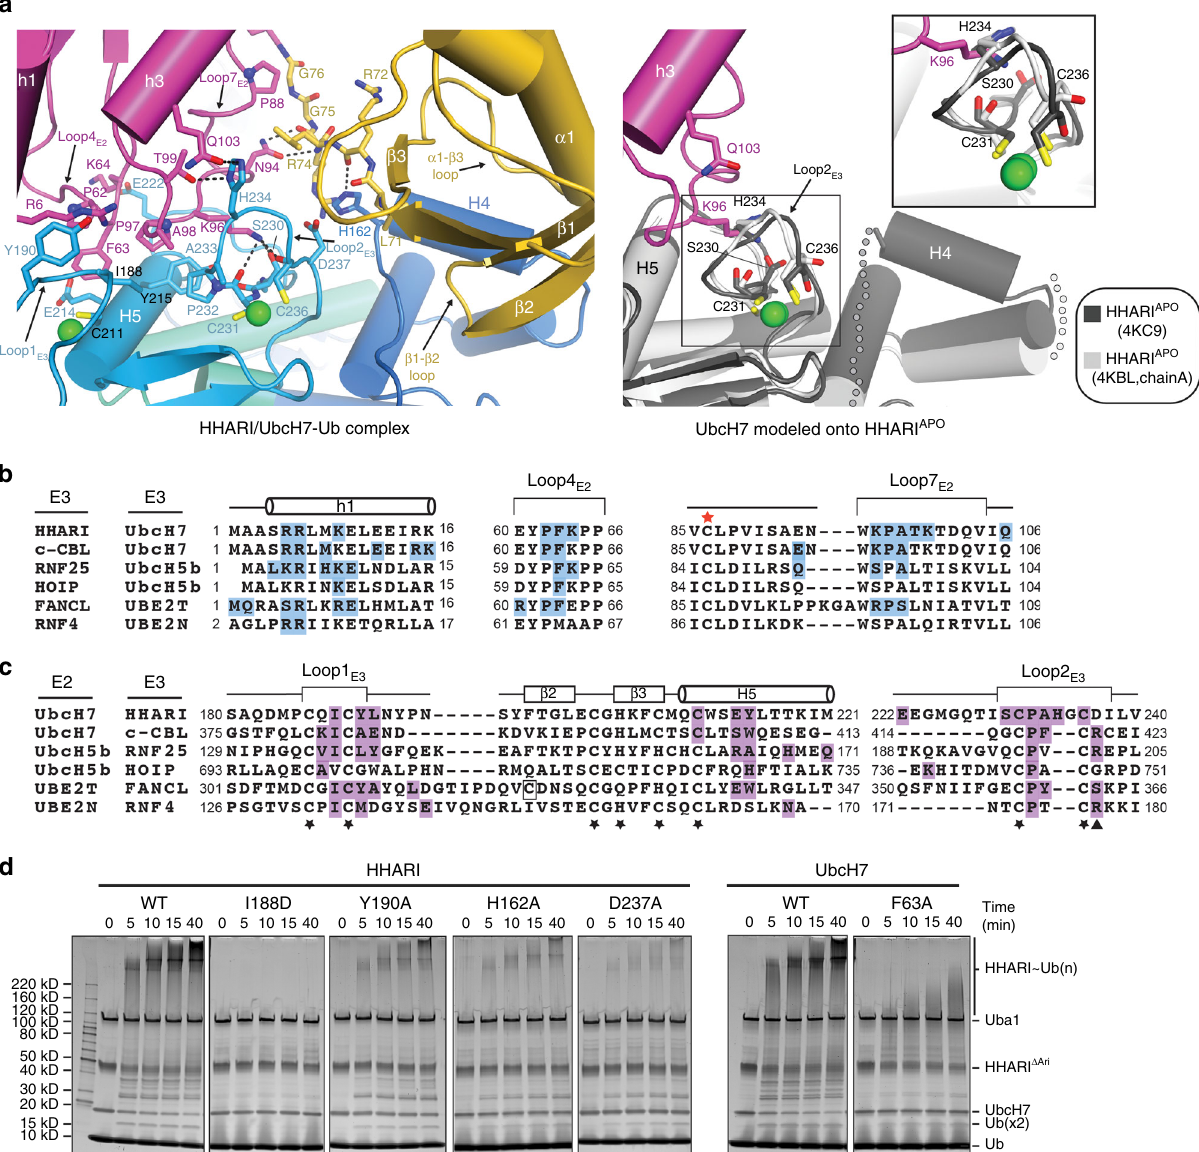
Fig. 3 The HHARI RING1 /UbcH7-Ub interface. a ( left ) Cartoon representation of the HHARI RING1 /UbcH7-Ub interface with residues involved in intermolecular interactions shown as sticks. Zinc ions are shown as green spheres and hydrogen bonds are shown as dashed lines . ( right ) Model of an apo HHARI/UbcH7 complex created by superimposing RING1/UbcH7 from the HHARI/UbcH7-Ub structure onto RING1 of apo HHARI structures. Disordered regions in the UBA-like domains of apo HHARI that become ordered upon UbcH7-Ub binding are shown as semitransparent gray spheres . A magni fi ed view of The HHARI Loop2 E3 region is boxed and a magni fi ed view is shown in the inset . b Structure-based sequence alignment of RING-interacting regions of selected ubiquitin E2s. E2 residues involved in contacts to the indicated RING domain are colored blue , the catalytic cysteines are indicated with a red star , and dashes indicate gaps in the alignment. Structures used to prepare the fi gure are c-CBL/UbcH7 (PDB:1FBV), RNF25/UbcH5b (PDB:5D1L), HOIP/ UbcH5c (PDB:5EDV), FANCL/UBE2T (PDB:4CCG), and RNF4/Ube2N (PDB:5AIT). c Structure-based sequence alignment of ubiquitin E2-interacting regions of selected RING domains. RING domain residues involved in contacts to the indicated ubiquitin E2 are colored magenta , and the conserved zinc coordinating residues are indicated with black stars . The ‘ linchpin ’ arginine residue of canonical RING E3s is indicated with a black triangle . An atypical residue involved in zinc atom coordination (Cys324 of FANCL) is highlighted with a black box in the alignment. Structures used to prepare the alignment are the same as in b . d Structure-function analysis of the HHARI RING1 /UbcH7-Ub interface. WT and mutant proteins were utilized in HHARI autoubiquitination assays for the indicated time points, as described in the Methods section. Full-length HHARI is catalytically inactive due to Ariadne domain-mediated autoinhibition so a catalytically active HHARI construct lacking the Ariadne domain (HHARI Δ Ari ) was used in these assays, as previously described